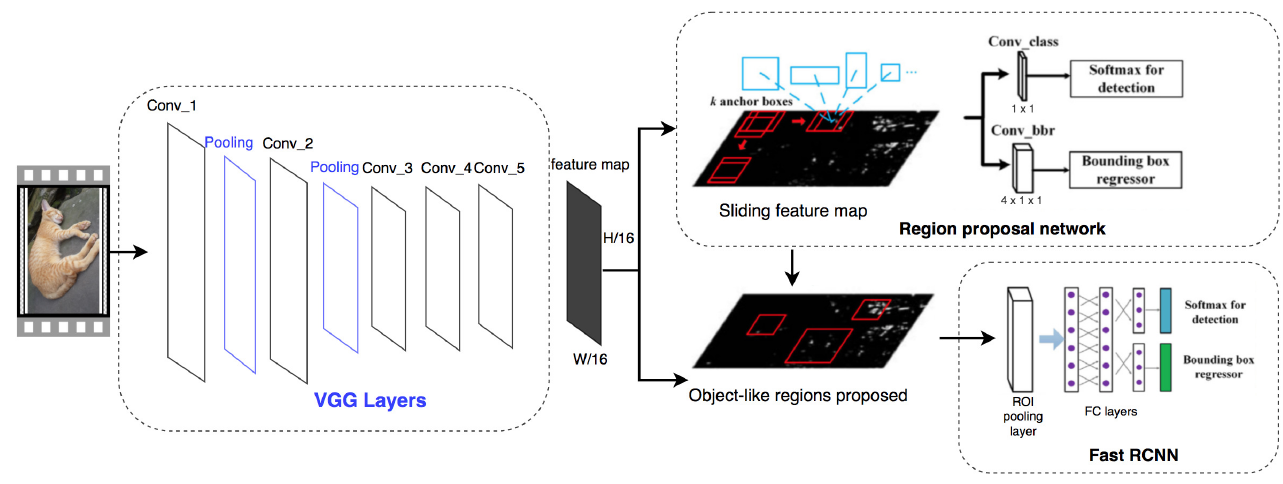
Figure 3. Faster R-CNN ResNet architecture.